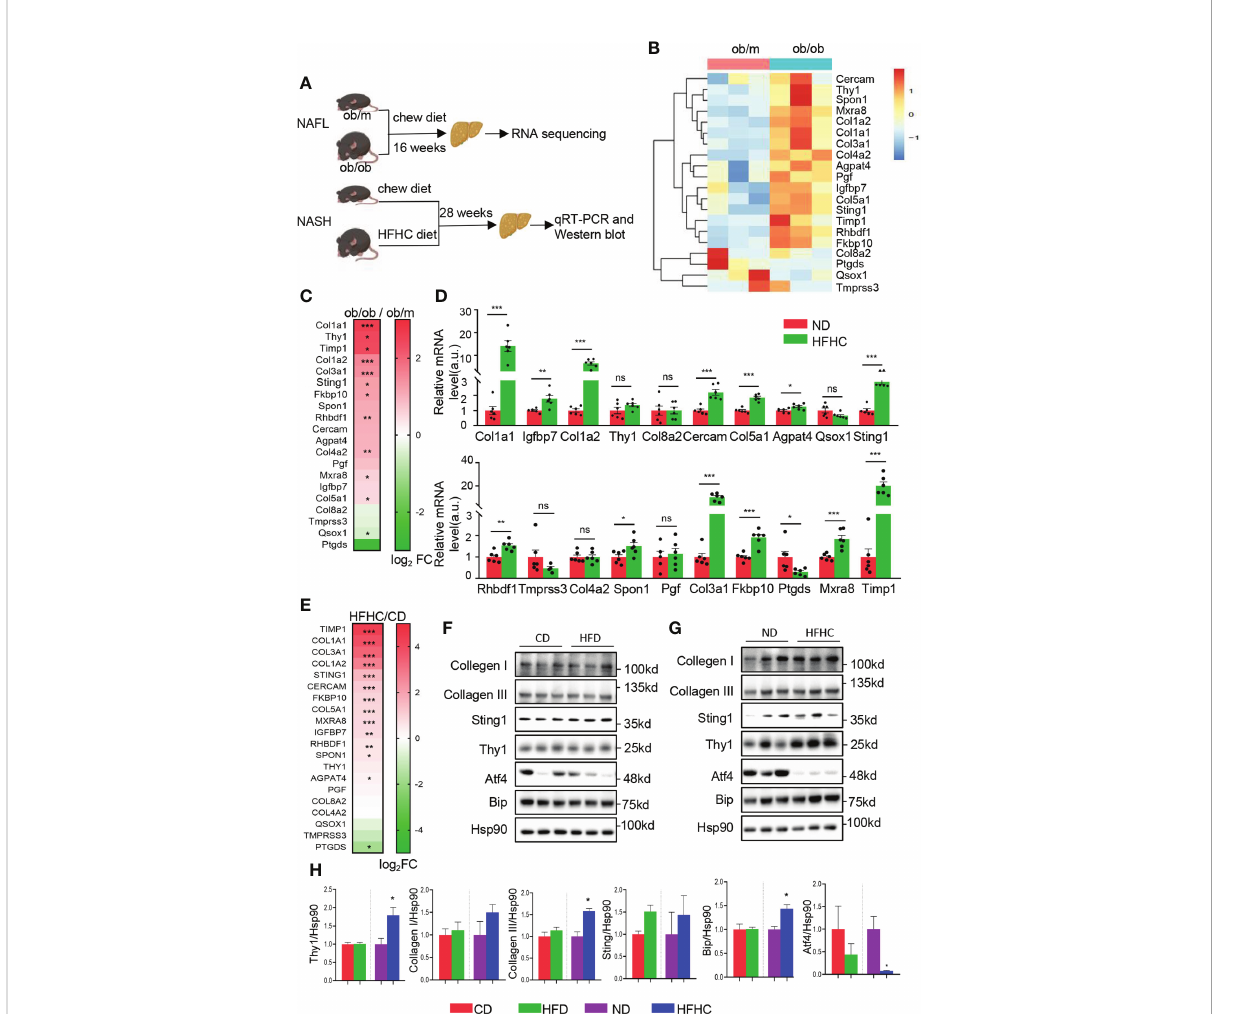
FIGURE 5 Validation of the top 20 hub genes from brown module on NAFLD mice models. (A) Schematic diagram of animal experiments. Ob/m and ob/ob mice were fed with chew diet for 16 weeks to establish NAFL mice model and livers were harvested for RNA sequencing. C57BL/6 mice fed with HFHC diet or normal chew diet for 28 weeks to establish NASH mice model and livers were harvested for qRT-PCR and Western blot. (B) The heatmap represents relative expression of the top 20 hub genes in livers of ob/m and ob/ob mice determined by RNA sequencing. (C) Heatmap of the top 20 hub genes of ob/m and ob/ob mice, colored by log 2 fold change determined by RNA sequencing. (D) mRNA level of the top 20 hub genes in livers were determined by qRT-PCR with quanti fi cation (n=6). Each experiment had 2 technical replicates. (E) Heatmap of the top 20 hub genes of HFHC-fed and control mice, colored by log 2 fold change determined by qRT-PCR. (F – H) . The protein level of top ranked hub genes identi fi ed by ROC analysis were determined in NAFL, NASH and corresponding control mice by Western blots (F, G) with quanti fi cation (n=3) (H) . Data are represented as means ± SEM. * P < 0.05, ** P < 0.01 and *** P < 0.001. ns, not signi fi cant; ROC, receiver operating characteristic; HFD, high fat diet mice; CD, the control for HFD mice; HFHC, high-fat and high-cholesterol diet mice; ND, the control for HFHC mice. ns, not signi fi